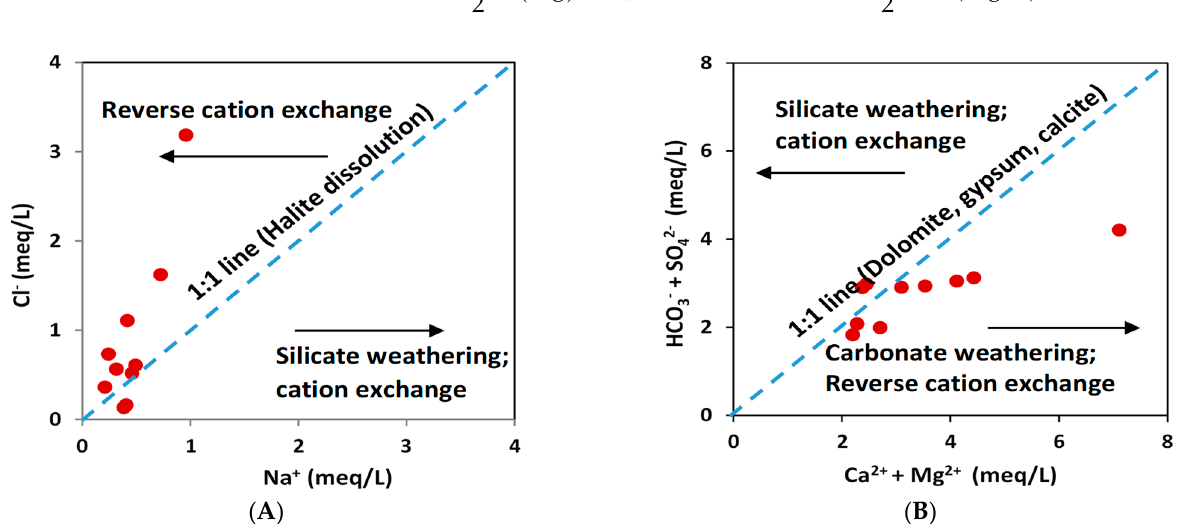
Figure 6. Bivariate plots of ( A ) Na versus Cl and ( B ) (SO 42- + HCO 3 − ) versus (Ca 2+ + Mg 2+ ).